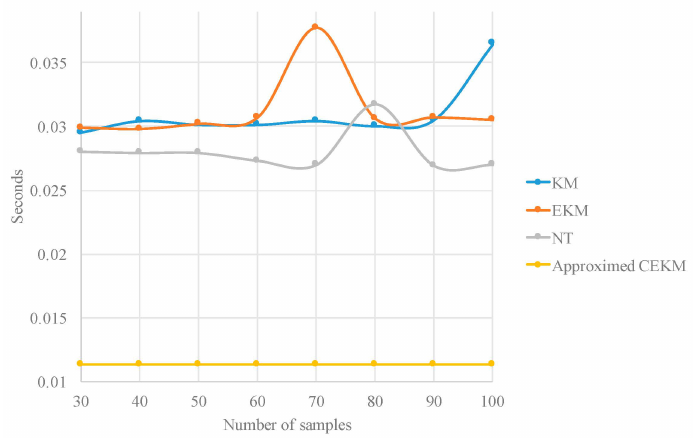
Figure 7. Execution time comparison of the type-reduction